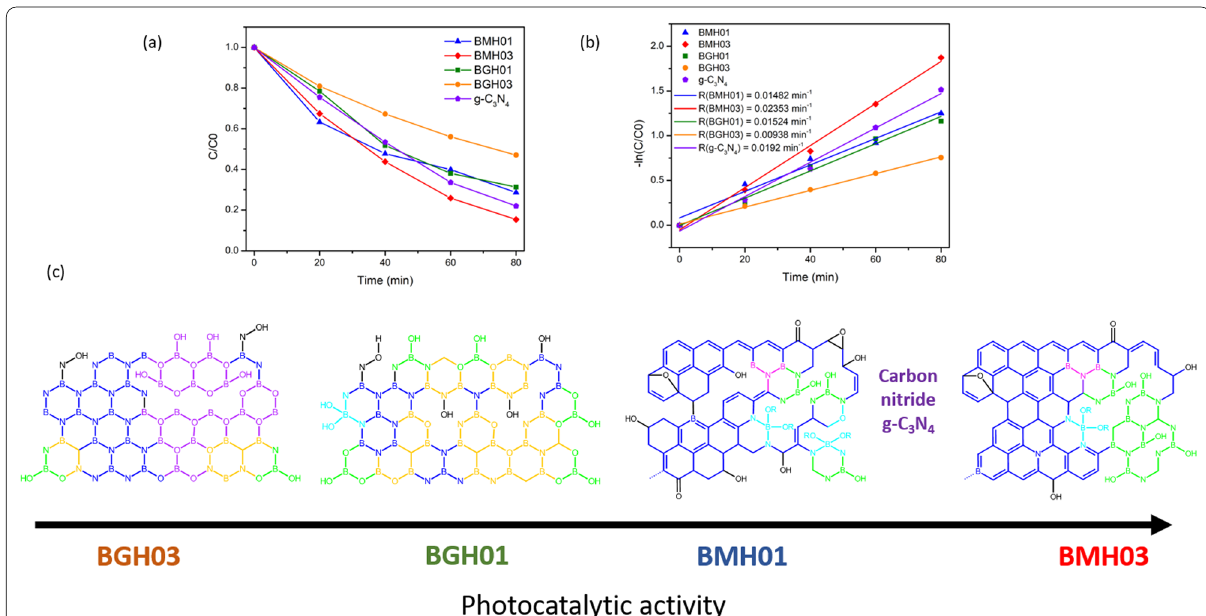
Fig. 7 UV–visible light‑induced photocatalytic MB degradation using BGH and BMH. a Photodegradation of MB under UV–visible light (plot of C / C 0 ) and b pseudo‑first‑order rate reaction kinetics for MB dye using BGH, BMH, and CN as a photocatalyst. c The proposed structures for BGH01, BGH03, BMH01, and BMH03 and their corresponding activities toward photodegradation of MB dye. Each domain is color‑coded, i.e., BCNO (orange), h‑BN and graphene oxides (blue), tricoordinate boron BN 2 (OH) and BO 2 (OH) (green), boroxol ring (purple), tetracoordinate B sites (aqua blue), and functional groups or dangling bonds